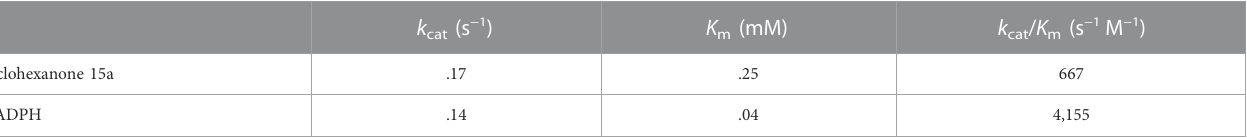
TABLE 1 Kinetic parameters of Msme AmDH for the KRED activity.